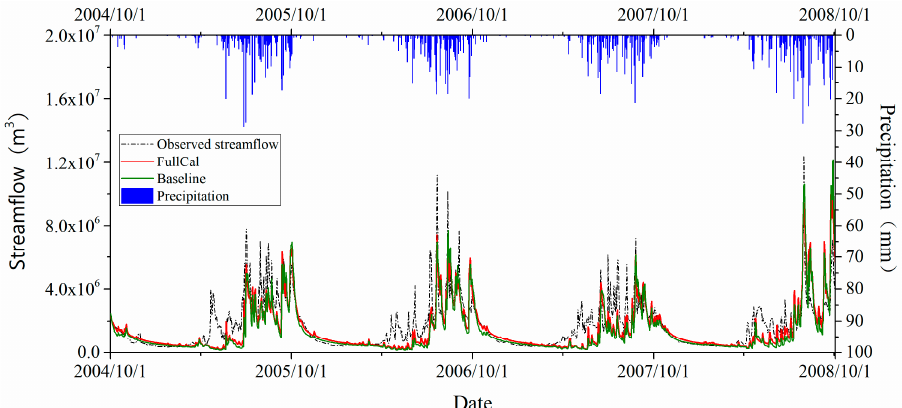
Figure 4. Simulated daily streamflow with the parameters optimized in the baseline and full stratification calibration, respectively, in a four-year validation period (1 October 2004–30 September 2008). Table 5. The values of Nash–Sutcliffe efficiency (NSE), Kling–Gupta efficiency (KGE) and root-mean-square error (RMSE) of the simulated daily streamflow with the parameters optimized in the baseline and full stratification calibration schemes, respectively, in a four-year validation period (1 October 2004–30 September 2008).